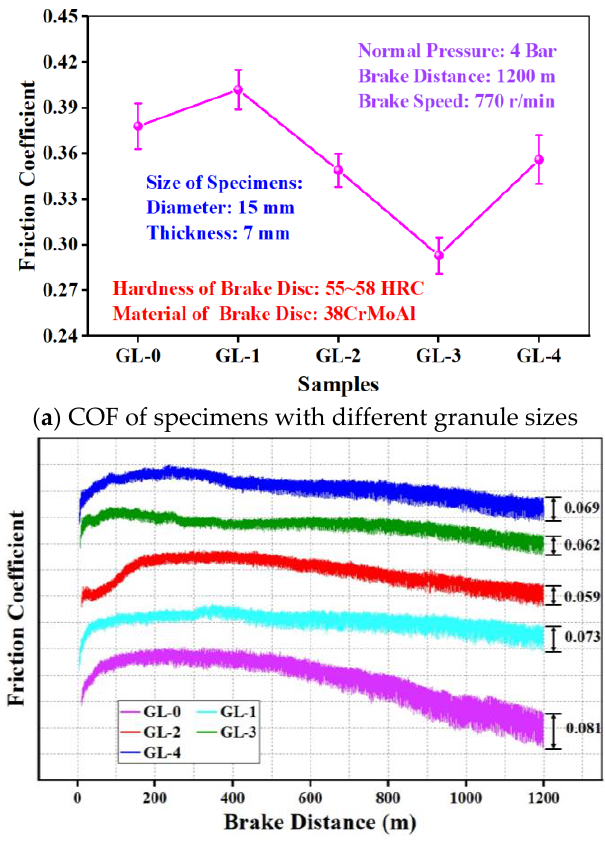
Figure 3. COF of specimens with different granule sizes.